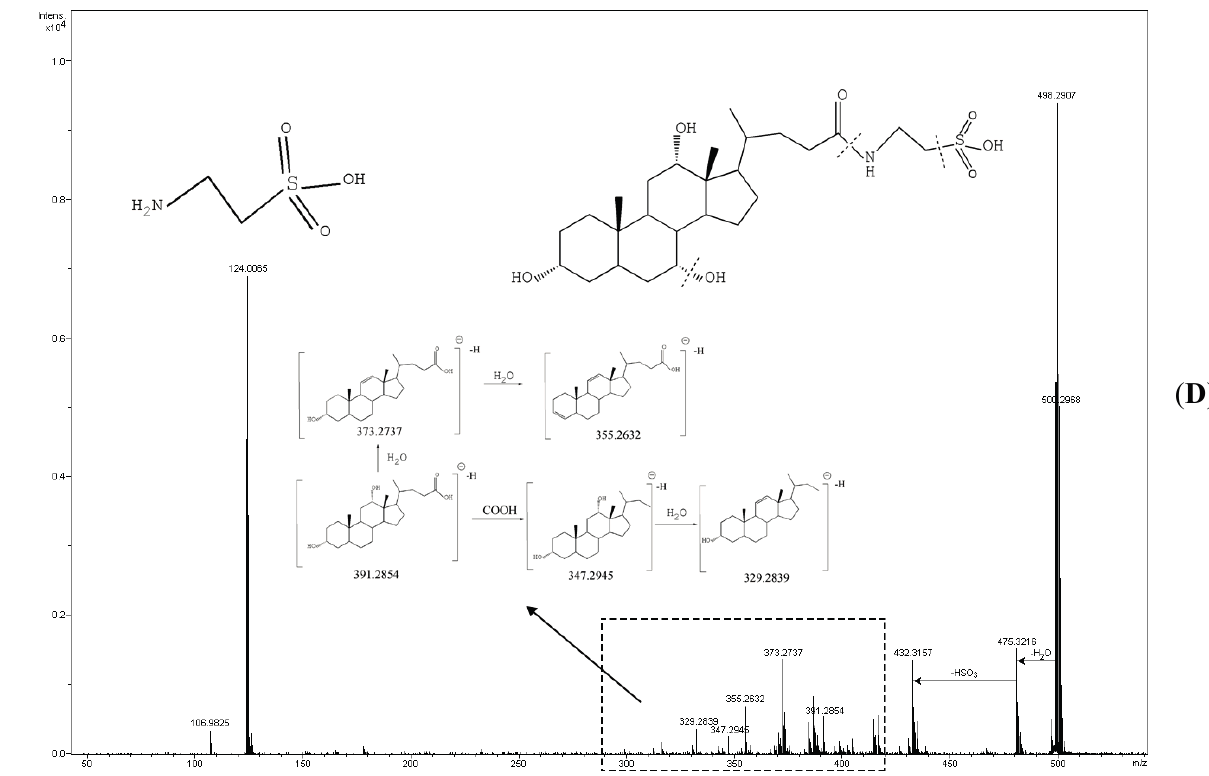
Figure 3. ( A ) The ESI-QTOF-MS spectra and the proposed fragmentation pathway of ginsenoside Rb1; ( B ) The ESI-QTOF-MS spectra and the proposed fragmentation pathway of tanshinone IIA; ( C ) The ESI-QTOF-MS spectra and the proposed fragmentation pathway of gamabufotalin; ( D ) The ESI-QTOF-MS spectra and the proposed fragmentation pathway of